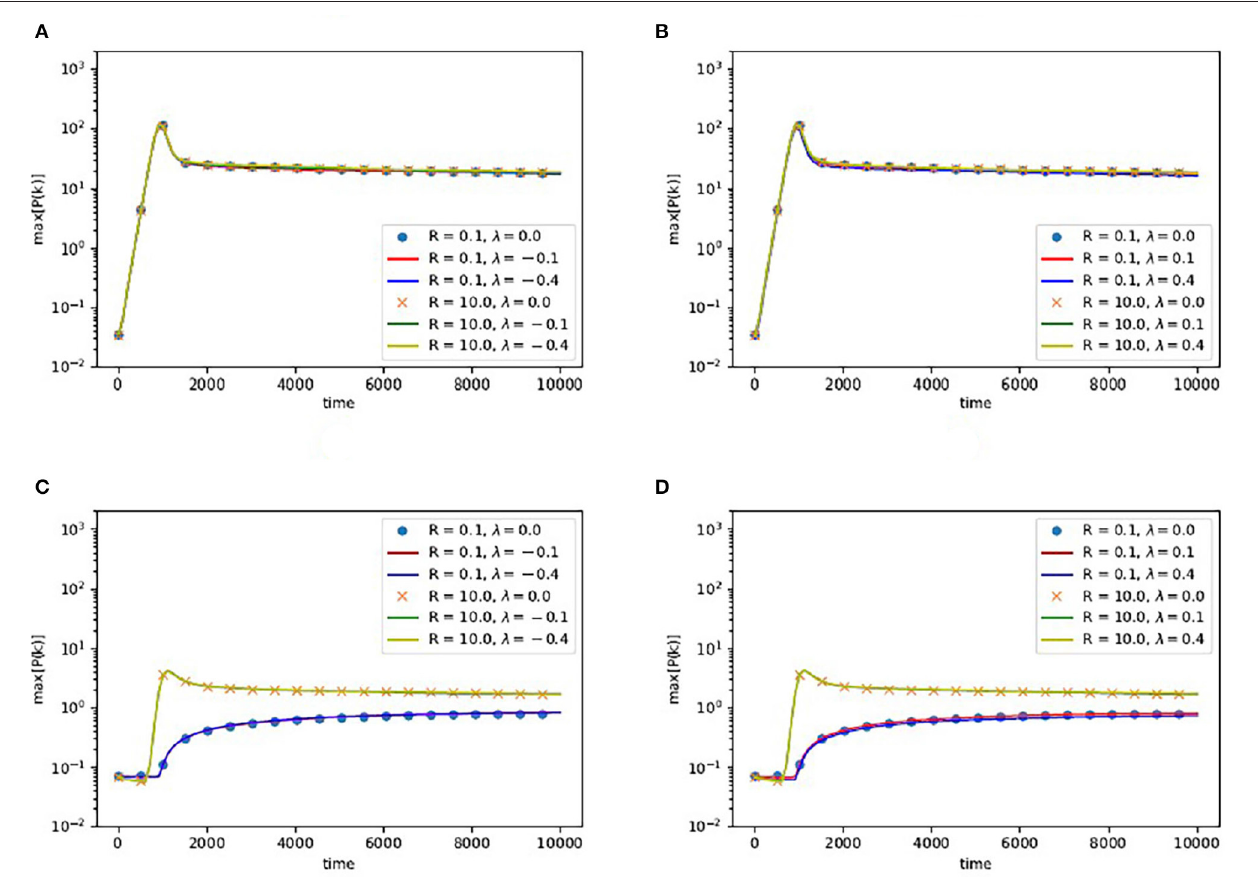
FIGURE 7 | The time evolution of the maxima of power spectra, from the tensor equations incorporating anchoring (14) with NP mobility R =0.1 and R λ the nematization when 0.4 0 (planar anchoring), (B) the nematization when 0 − ≤ ≤ λ 0.4 0 (planar anchoring), and (D) the NP concentration when 0 − ≤ ≤ data for λ 0. For the weak anchoring conditions and low initial NP concentration c 0 = dependence with the value of the anchoring parameter. Parameters g